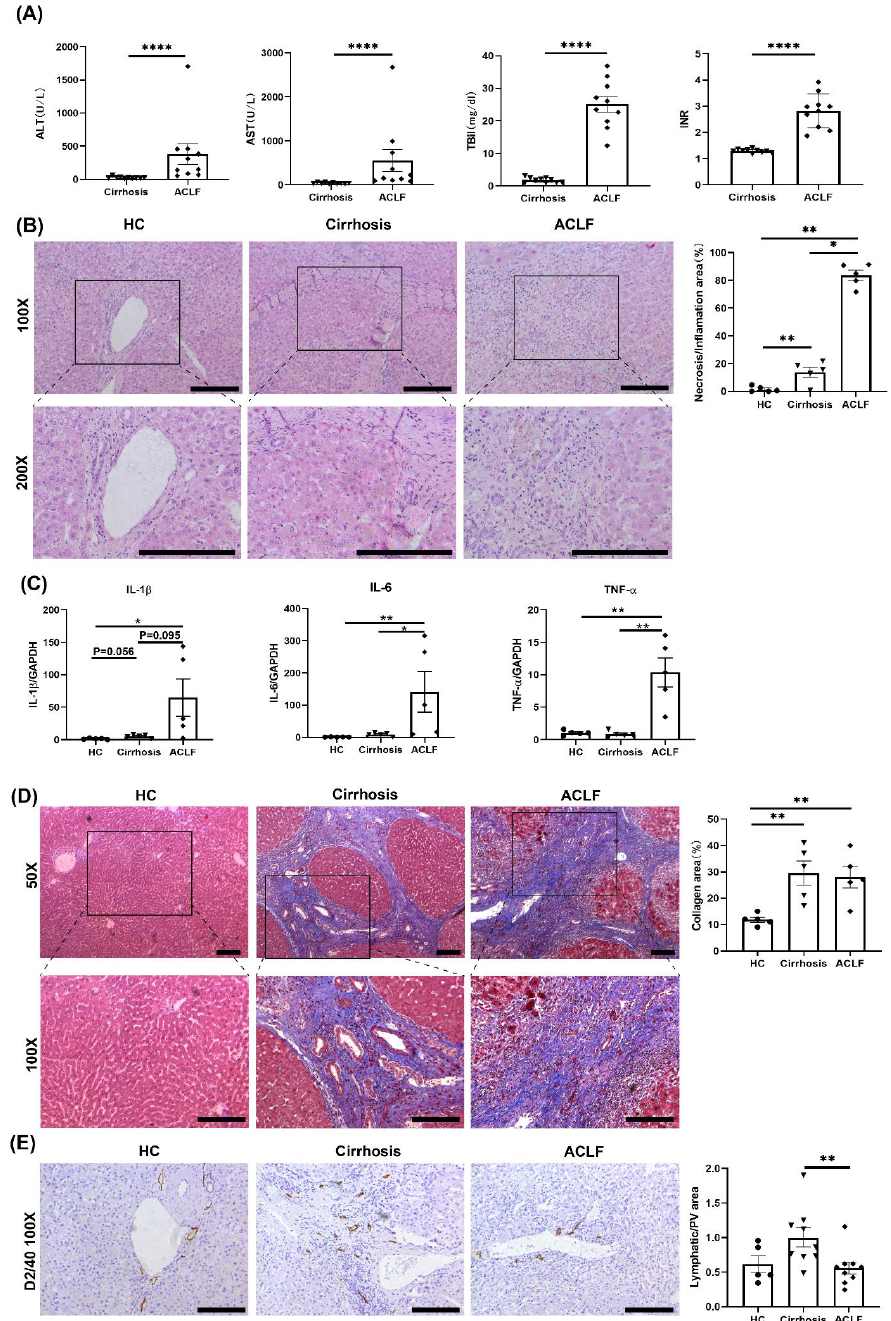
Figure 1. ACLF patients exhibited more severe liver damage and inflammation and fewer LVs than cirrhosis patients. ( A ) The plasma level of ALT, AST, TBil, and INR of enrolled 25 patients. ( B ) H&E staining of liver tissue among HCs, cirrhosis patients, and ACLF patients. ( C ) The mRNA expression of proinflammatory cytokines (IL-1 β , IL-6, and TNF- α ) in the liver of ACLF compared to that in cirrhosis and HC group by qRT-PCR. ( D ) Masson staining of liver tissues among HCs, cirrhosis patients, and ACLF patients. ( E ) Representative IHC images of LVs (D2/40) in the liver among HCs, cirrhosis patients, and ACLF patients (100 × field) (* p < 0.05, ** p < 0.01, **** p < 0.0001; bar = 200 µ